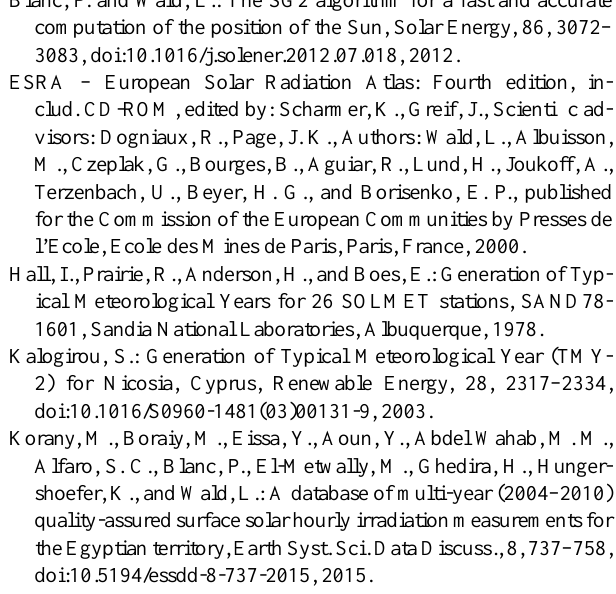
Figure 4. Correlogram between B Nh (horizontal axis) and B ∗ computed with θ eff,A5 (vertical axis) for the subset “low sun” (SZA: S solar zenith angle) for